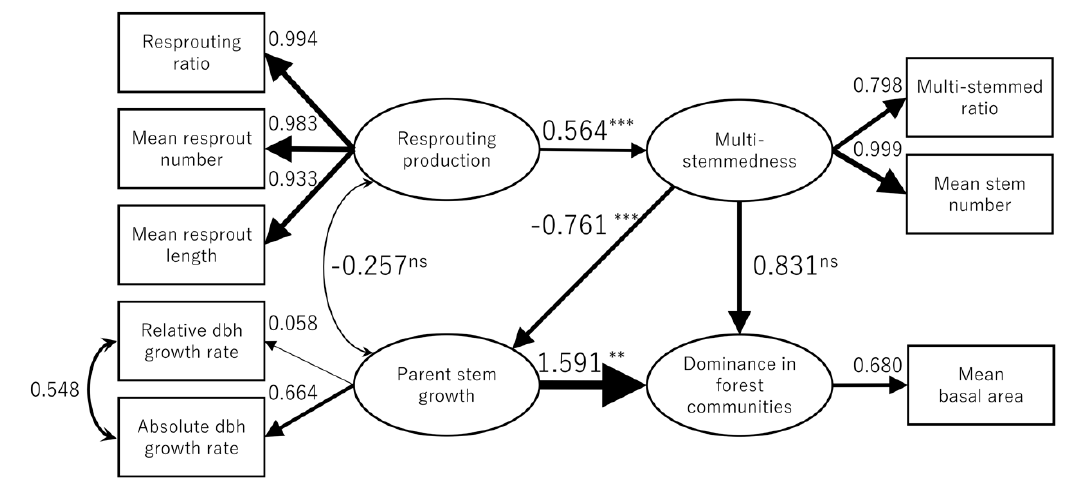
Figure 4. Final structural equation model summarizing relationships among resprout production, parent stem growth, multi-stemmedness, and dominance in forest communities. (ns: not signifcant; **: p < 0.01; ***: p < 0.001).